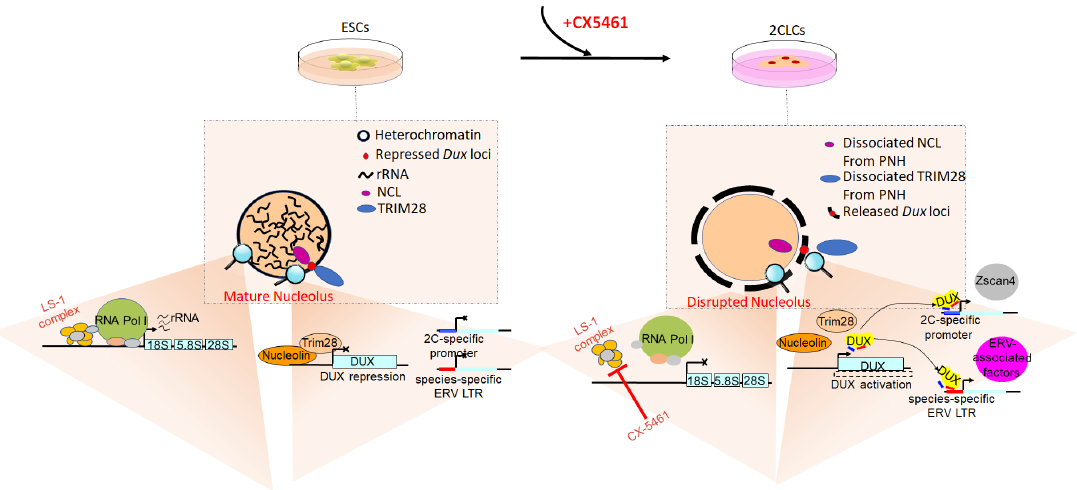
Figure 1. Scheme of cell fate conversion via rRNA biogenesis. In the mature nucleoli of embryonic stem cells (ESCs), high-abundance rRNA maintains nucleolar liquid–liquid phase separation (LLPS) and integrity, thus facilitating nucleolin (NCL)/tripartite motif-containing 28 (TRIM28) complex oc- cupancy on DUX loci, causing DUX repression in perinucleolar heterochromatin. ESCs do not dis- play transcriptome features similar to those of 2-cell-stage embryos, especially without DUX activa- tion. In contrast, in the disrupted nucleolus of 2-cell-like cells (2CLCs), adding CX-5461 inhibits the recruitment of the selective factor 1 (SL-1) complex and polymerase I (Pol I) initiation factor to rDNA, thus impairing rRNA synthesis. The inhibition of rRNA synthesis interferes with nucleolar LLPS and then disrupts nucleolar integrity and causes dissociation of the NCL/TRIM28 complex from DUX loci, providing a permissive environment for DUX derepression. Furthermore, DUX functions as a core transcription factor for zygotic genome activation (ZGA) and drives the expres- sion of MERVL and 2-cell-specific genes (e.g., Zscan4 ), which allow 2CLCs to obtain transcriptome features that resemble those of 2-cell-stage embryos. The NPBs in pseudo-pronuclei of cloned embryos exhibit abnormalities and may cause the different developmental potential observed between cloned and fertilized em- bryos [73,74]. Recent research has also demonstrated that transiently inhibiting rDNA transcription via CX-5461 in donor somatic cells can improve the preimplantation devel- opment of cloned embryos [75]. As in the vast majority of somatic cells, DUX loci in mouse embryonic fibroblasts (i.e., the donor cells for SCNT) were found to be attached to the nucleolar periphery enriched for repressive histone marks; thus, DUX often fails to be reactivated during reprogramming in early cloned embryos [15,76,77]. Recently, Liao et al. found that following treatment with CX-5461, upstream binding factor (UBF) fluores- cence intensity was less, and the number of black silver particles declined in the cumulus cells, indicating that CX-5461 treatment inhibited the activity of rDNA and then acceler- ated the deterioration of the mature nucleolus [75]. Using CX-5461-treated embryonic fi- broblasts as donor cells, further SCNT revealed that, compared with the control group, the early cloned embryos contained a more unconsolidated reticular-like ultrastructure in the nucleoli, resembling NPBs in early fertilized embryos. Importantly, the rate of blasto- cyst formation increased from 24% to 34% [75]. Taken together, we speculated that CX- 5461 accelerated nucleolar degeneration and enhanced the conversion of matured nucleoli of donor somatic cells into NPBs that are exclusive to early totipotent embryos, thus lead- ing to improvement in the preimplantation development of the treated cloned embryos.